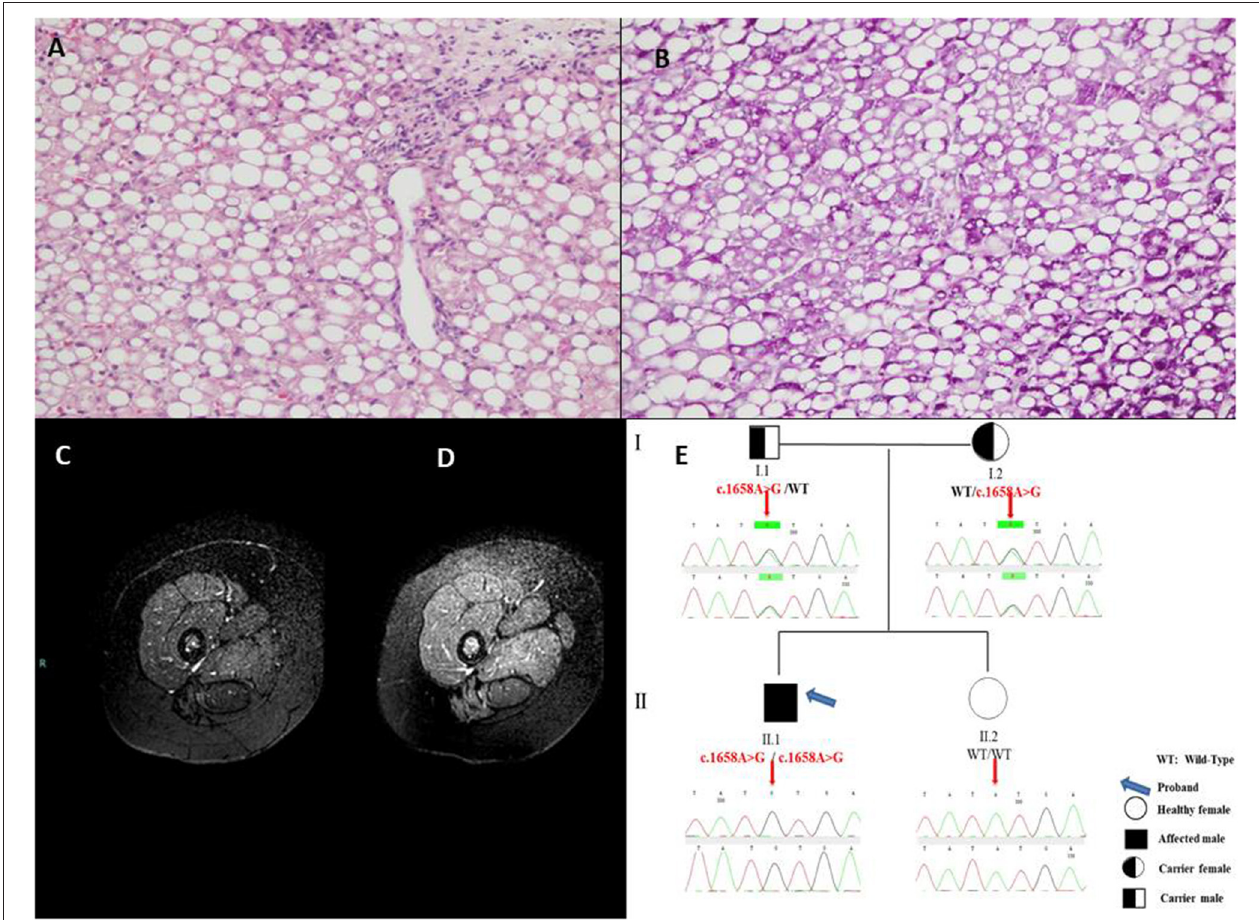
FIGURE 1 | (A) Massive micro-macrovacuolar steatohepatitis picture with minimal fibrosis at liver biopsy with hematoxylin-eosin 10 × and (B) Periodic Acid-Schiff, 20 × . (C) Magnetic Resonance examination in the pre-treatment showed the overall signal from thigh muscles slightly reduced and clearly inhomogeneous, due to the hypointensity of posterior muscles, compatible with a diffuse fat infiltration in a Fat-Suppressed acquisition technique. (D) After 10-month treatment the overall Magnetic Resonance signal from thigh muscles is higher and less inhomogeneous, with a signal increase of the posterior muscles indicating a reduced fat infiltration. (E) Pedigree of the family of the patient with Multiple Acyl-CoA Dehydrogenase Deficiency